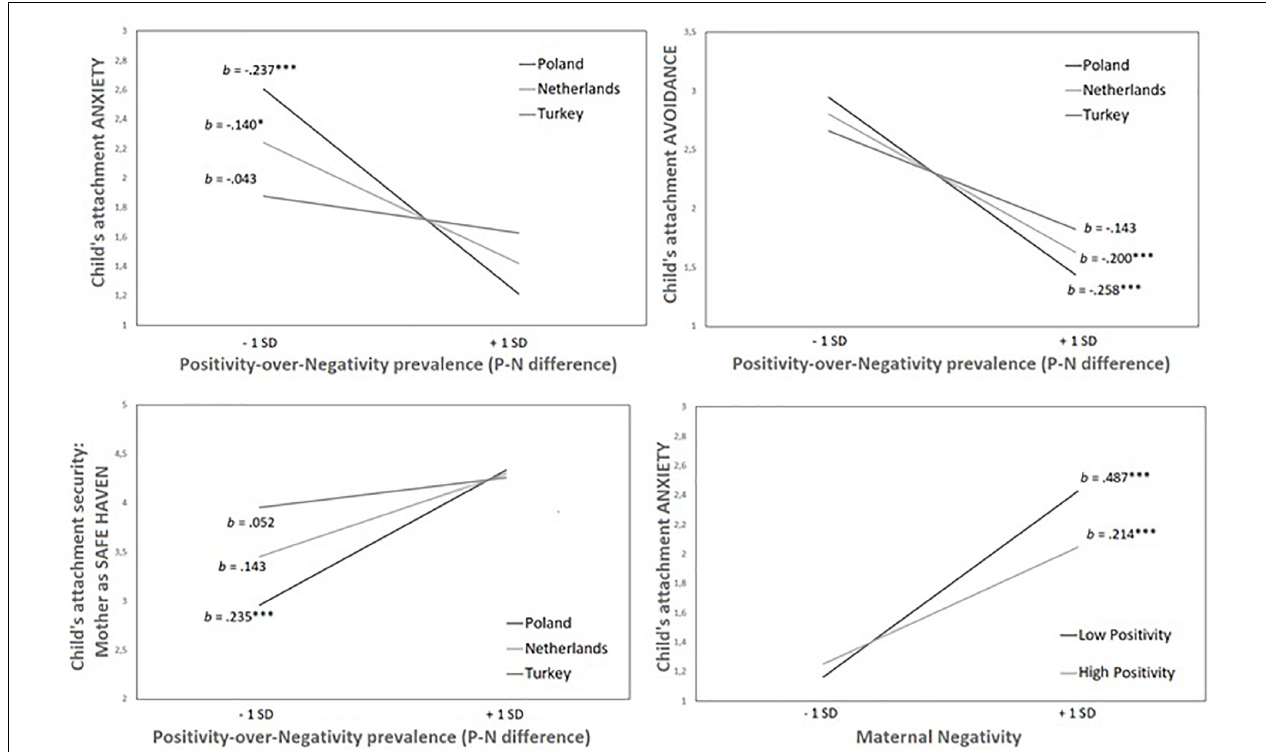
FIGURE 3 | Results of simple slope analyses explaining child’s attachment by: +/ − 1SD of maternal positivity-over-negativity prevalence depending on cultural group (upper panels and lower left panel); and low versus high maternal negativity level depending on high versus low maternal positivity level (lower right panel) in the total sample. All relations are significant at the levels of: ∗ p < 0.05; ∗∗∗ p <